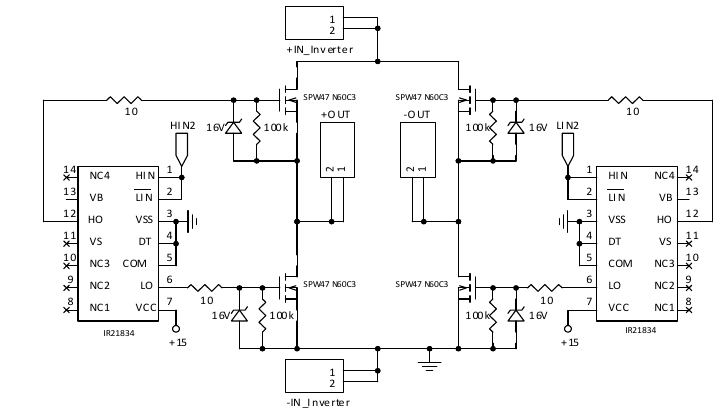
Figure 18. Power stage circuit of the proposed Quadratic Boost.